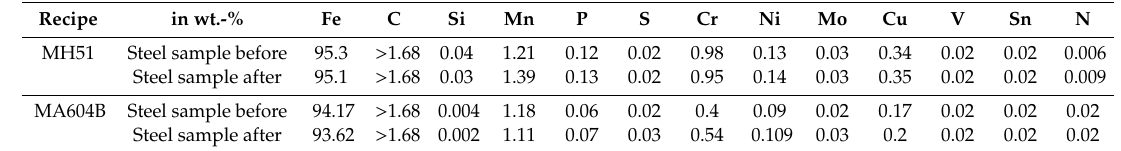
Table 6. Composition of the steel before and after adding the briquettes.